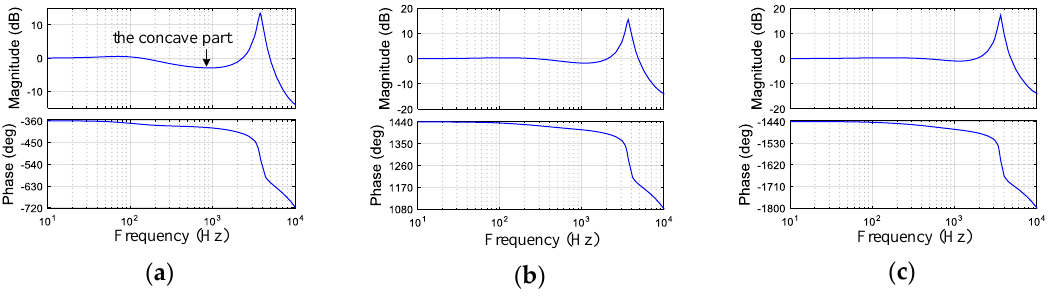
Figure 14. Bode diagrams of voltage closed-loop transfer function: ( a ) f z = 250 Hz; ( b ) f z = 550 Hz; ( c ) f z = 750 Hz.